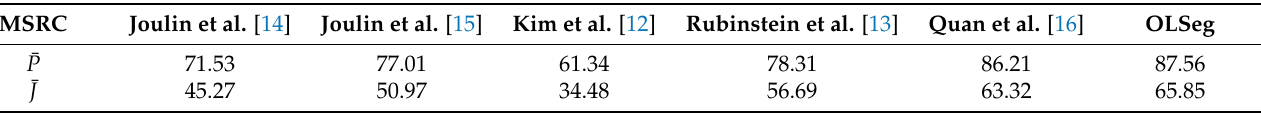
Table 4. Comparisons of ¯ P and ¯ J (%) on the MSRC dataset. The ¯ P and ¯ J denote the average precision and average Jaccard similarity,